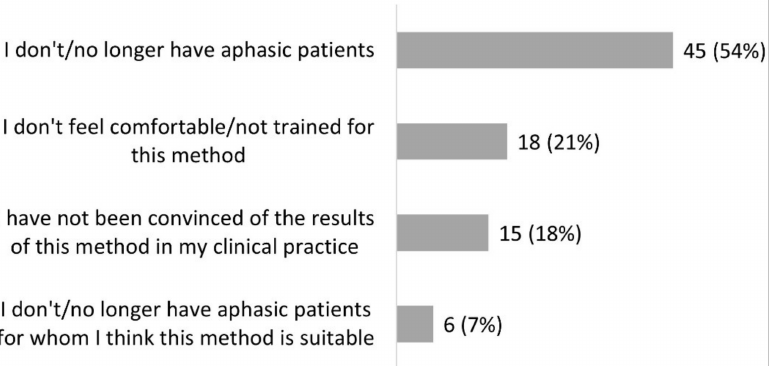
Figure 4. Reasons why participants no longer use melodic therapy (question #12 of the questionnaire, 74 respondents).